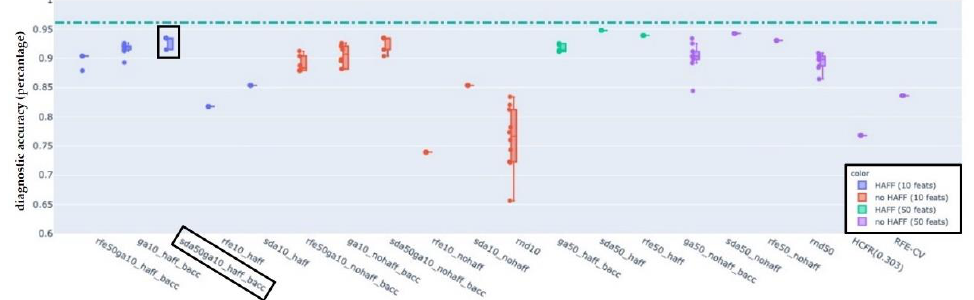
Figure 5. Balanced accuracy distributions of EFS-algorithms trained and evaluated on the LN-label “pathologic”. For reference, the BACC of the LDA classifier without feature count reduction is shown as a dash-dotted green horizontal line (at a value of 0.87). The combination of RFE and GA (black box) appeared to be the potentially most useful EFS-algorithms, retaining a diagnostic accuracy of >80% with only 10% of the features.